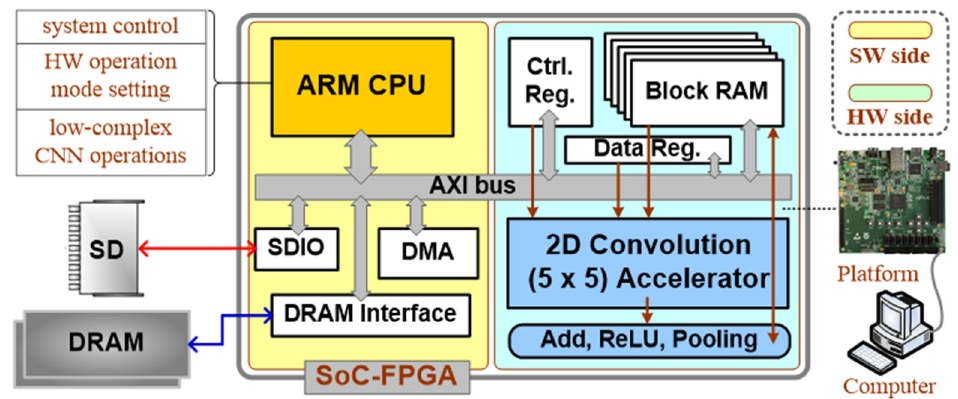
Figure 11. Schematic of the setup of our design implementation that uses a SoC-FPGA approach.